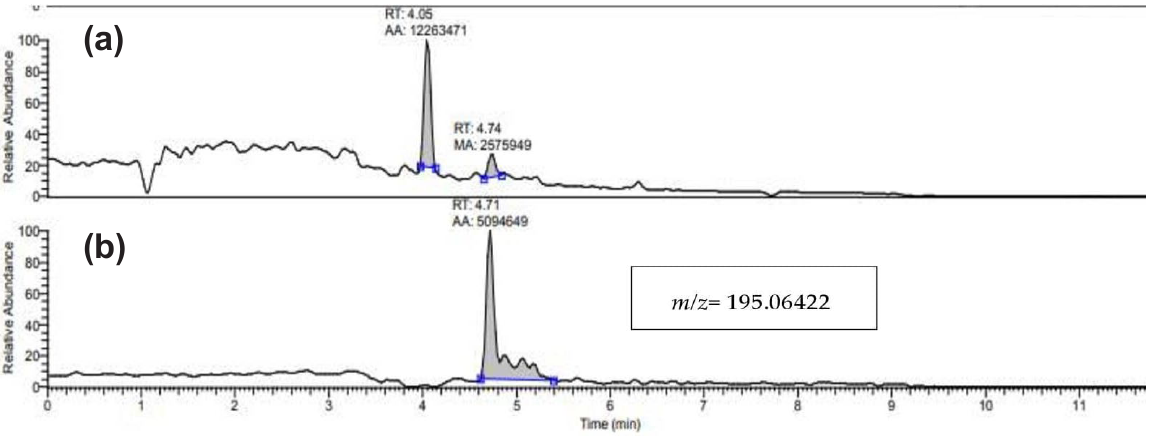
Figure 3 : Total Ion Chromatograms (TIC) for extract of dehydrated pulp and seeds of granadilla in 70% acetone and its main comparative standard, ferulic acid. (a) Granadilla extract. (b) Ferulic acid, reference